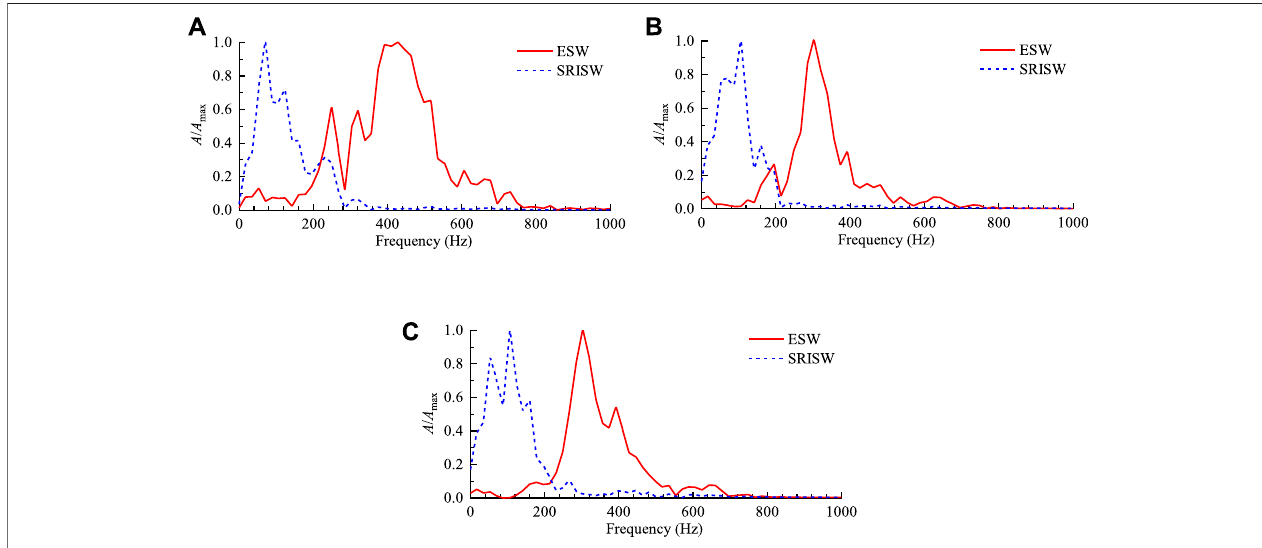
FIGURE 12 | Normalized amplitude-frequency spectra of the separated seismic waves. (A) Transverse component, (B) Vertical component, (C) Longitudinal component.